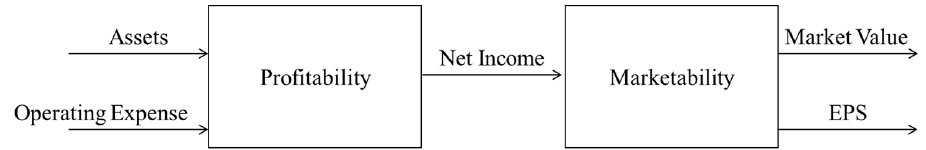
Figure 1. The modified two-stage value creation framework of financial holding companies.